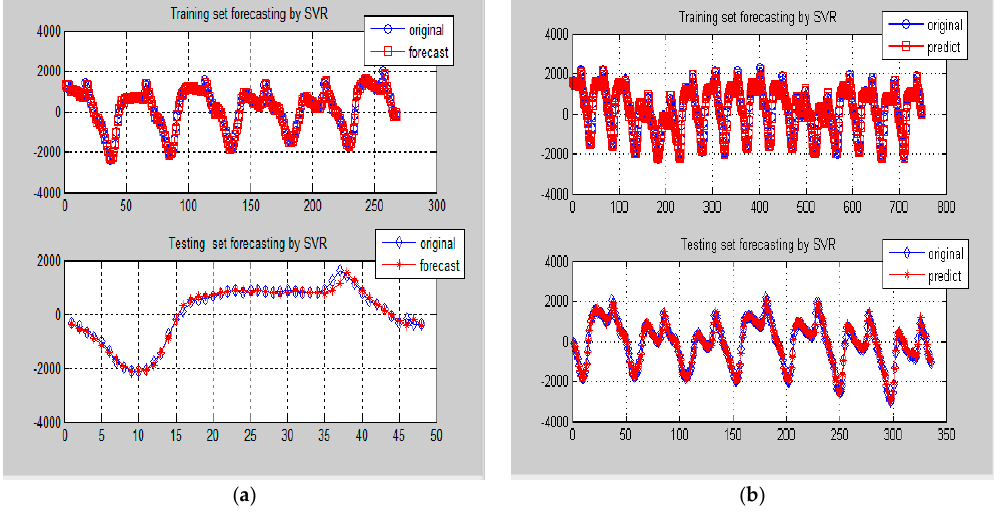
Figure 7. Comparison of forecasting results by SVR-PSO model for Data-I (Example 1). ( a ) One-day ahead forecasting on 8 May 2007; ( b ) One-week ahead forecasting from 18–24 May 2007. Table 1. The parameters settings of SVR-PSO model for original data and Data-I (Examples 1 and 2). Data Types